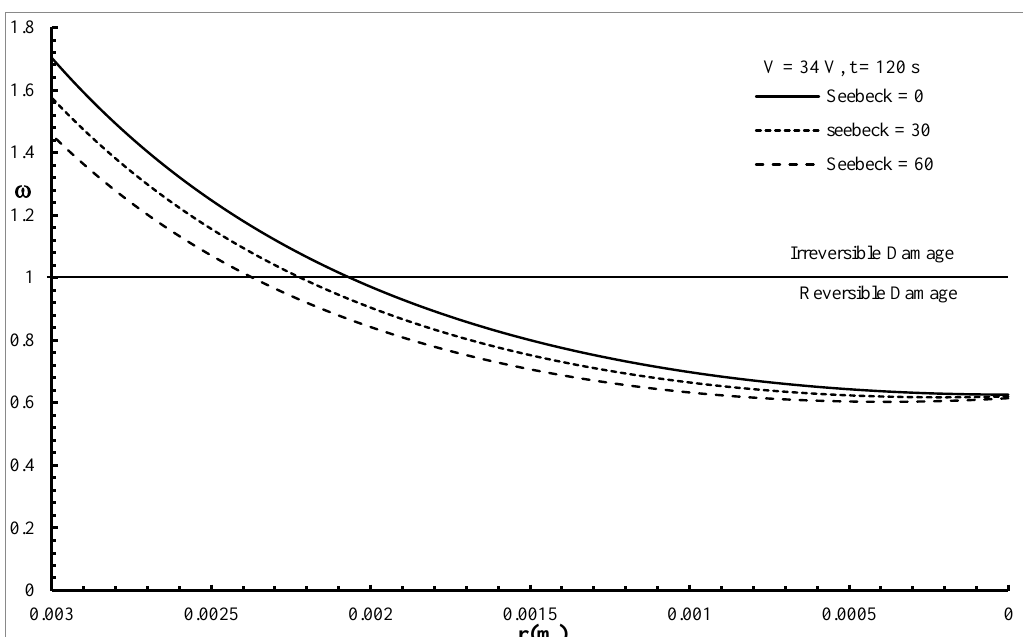
Figure 16. The thermal damage distribution of lipoma tumor with various values of time when 1300 R . e